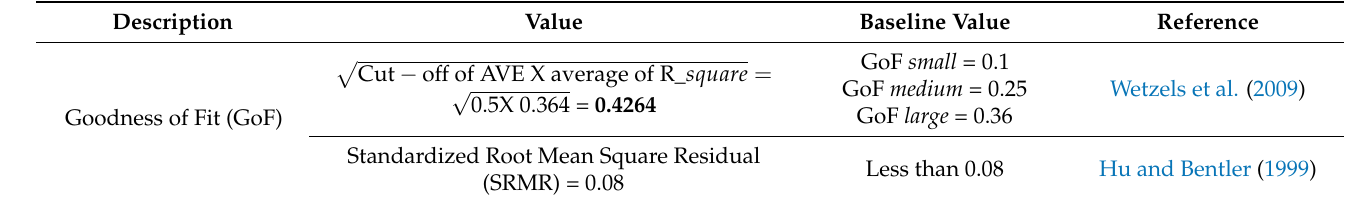
Table 7. Goodness-of-Fit.